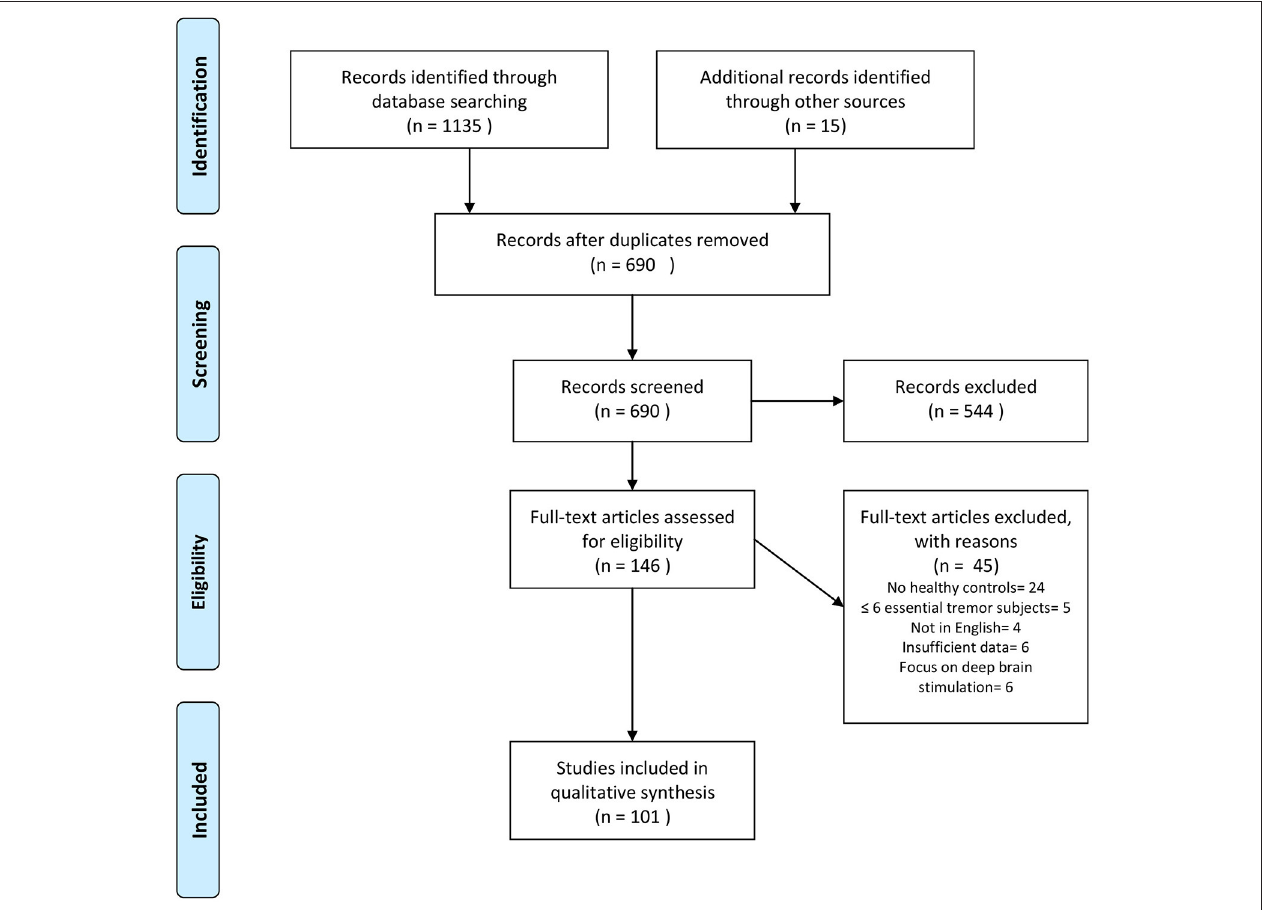
FIGURE 1 | Flowchart depicting the study selection process. Search was performed in PubMed and Scopus up to December 2020. Modified from Moher et al. (20).